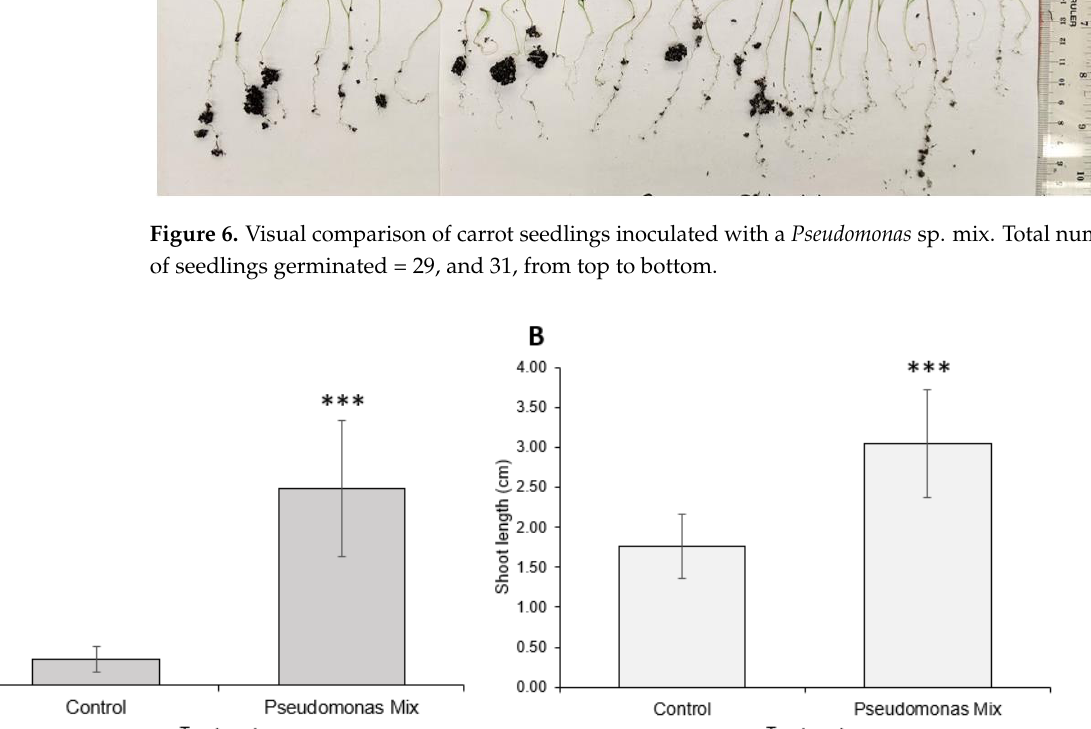
Figure 7. Carrot growth promotion by a mix of Pseudomonas sp. strains. ( A ) Root and ( B ) shoot lengths of 2-week-old carrot seedlings inoculated with Pseudomonas sp. P3AW, AY2, WC, and WCY. Error bars represent standard deviation. Asterisks represent the p value of the Student’s T -test con- ducted between the control and the experimental group. ns = p > 0.05, * = p ≤ 0.05, ** = p ≤ 0.01, *** = p ≤ 0.001.